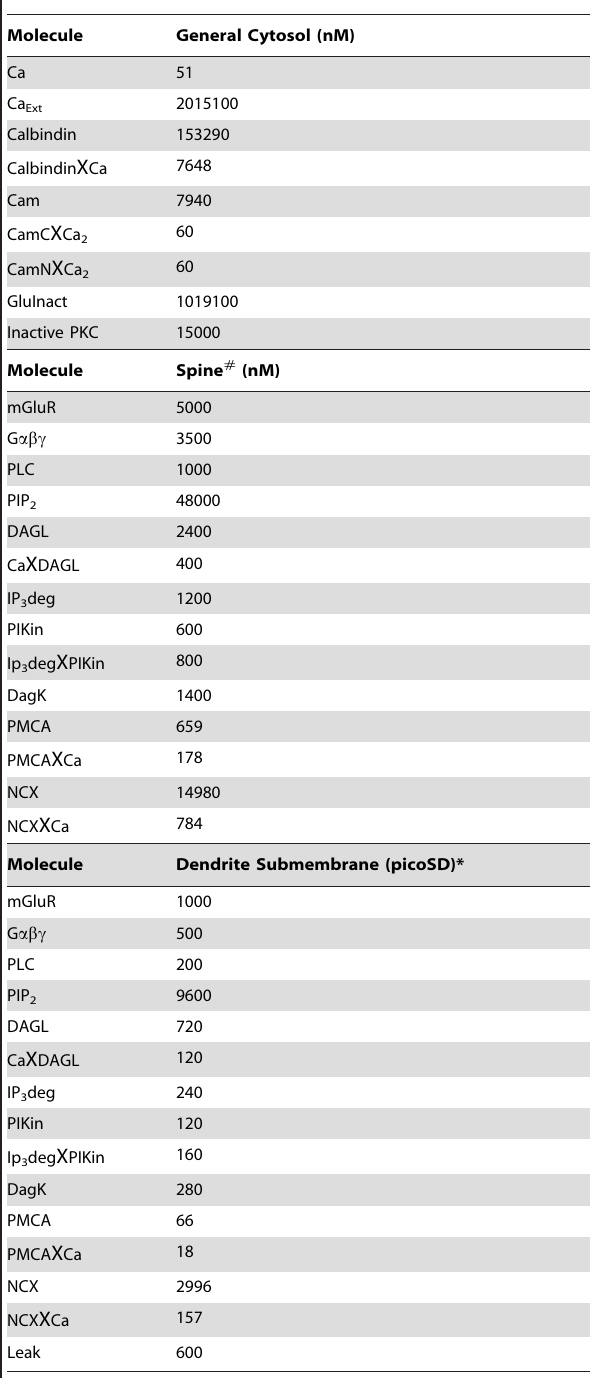
Table 2. Initial concentrations of molecule species in the simulation.